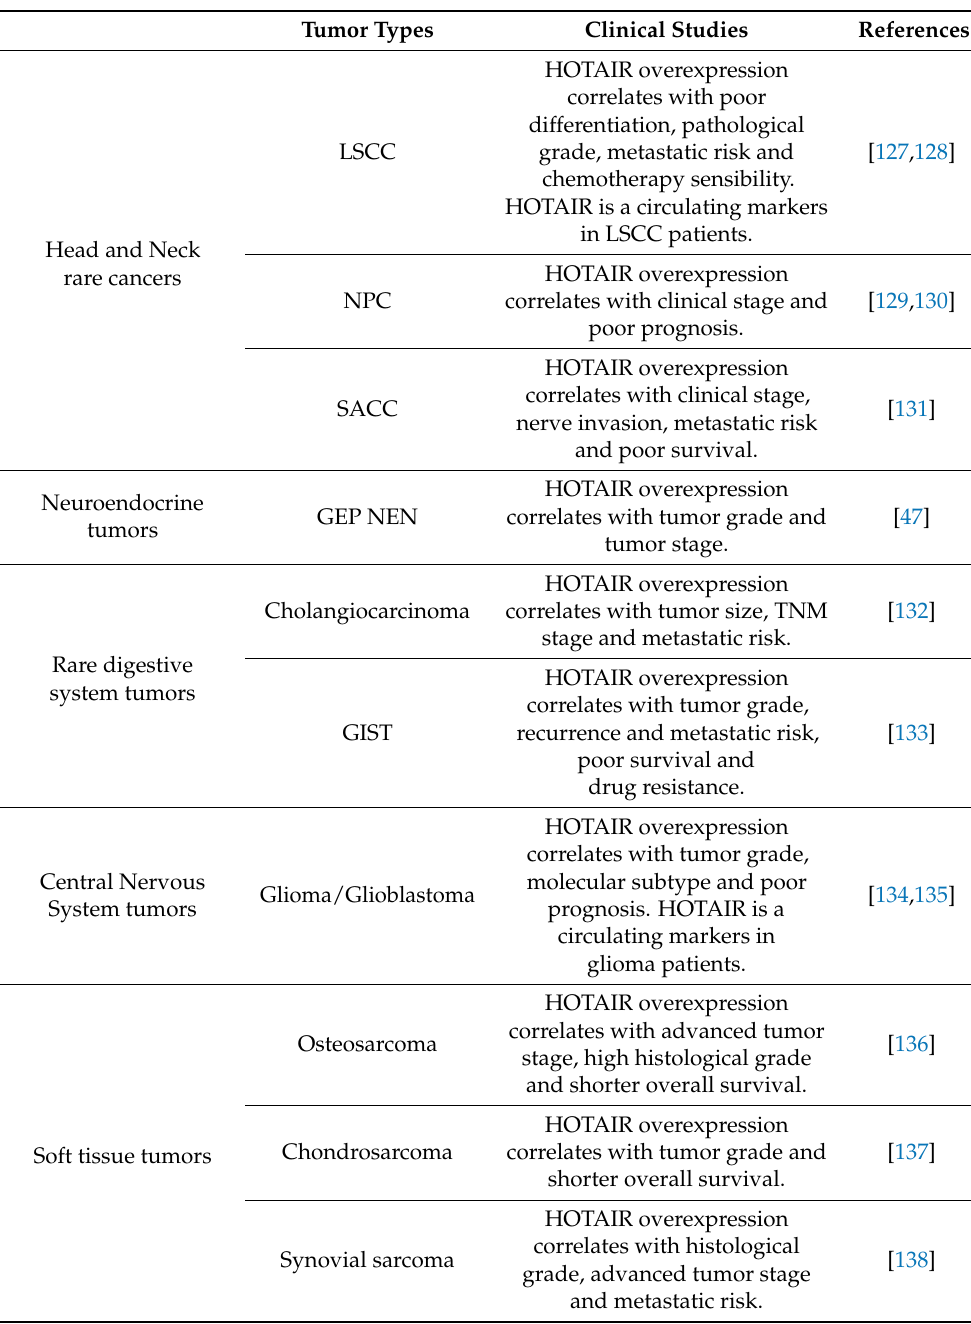
Table 2. Principal roles of HOTAIR in patients with rare